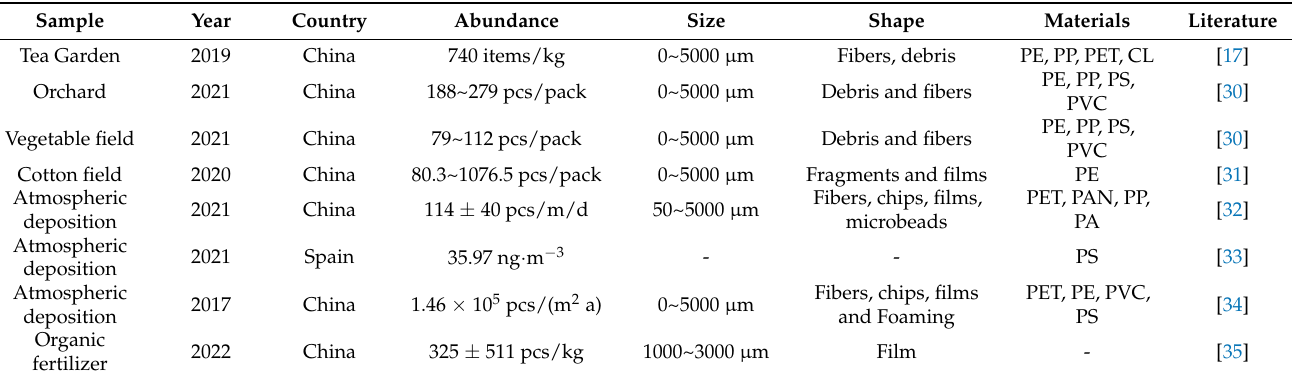
Table 2. Sources of microplastic contamination in